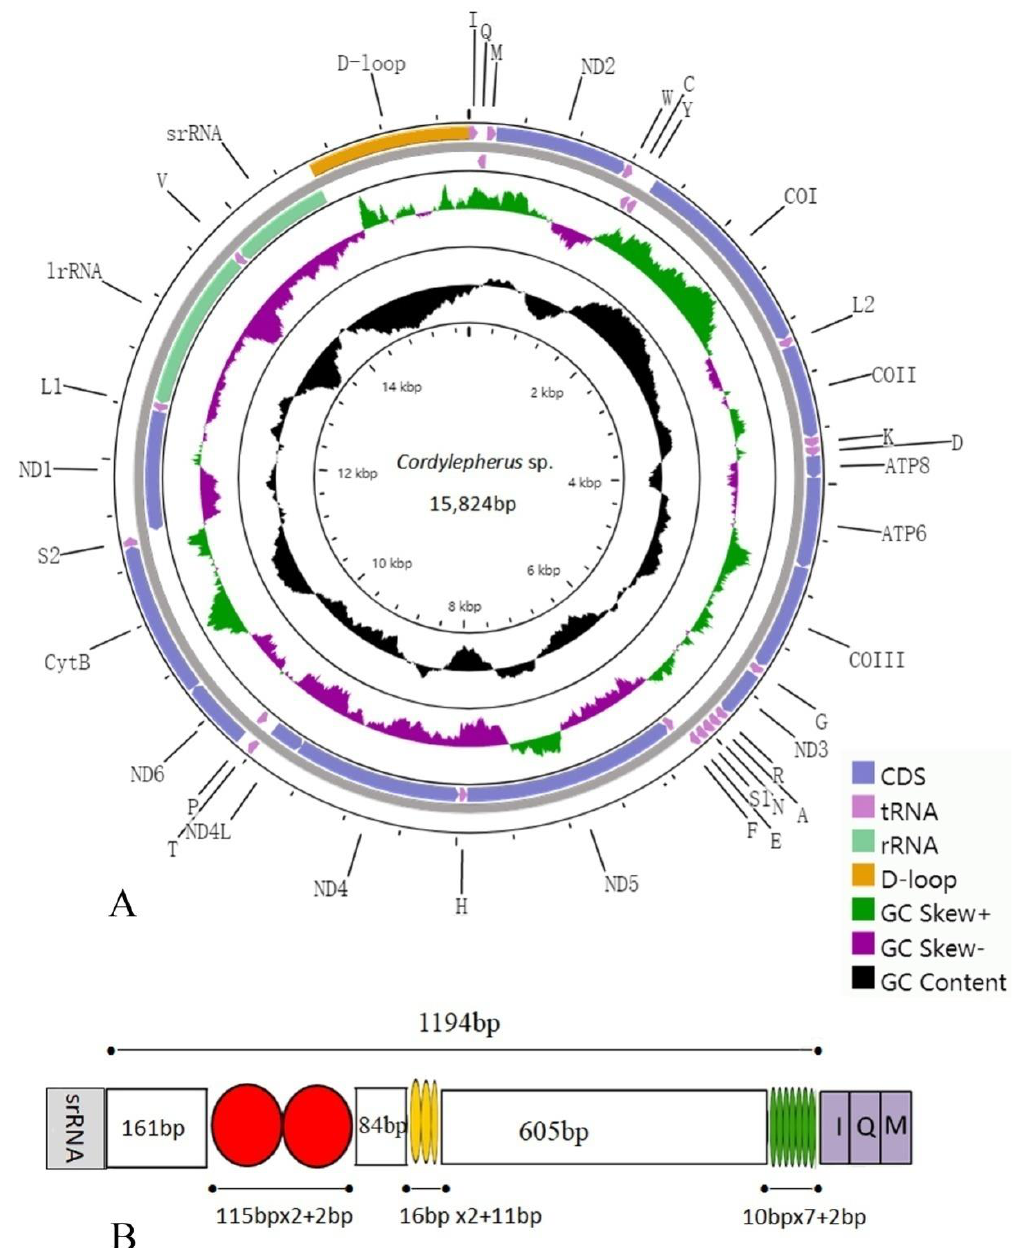
Figure 1. ( A ) Mitochondrial genome map of Cordylepherus sp.; ( B ) organization of the A + T-rich regions in the mitochondrial genomes of Cordylepherus sp.